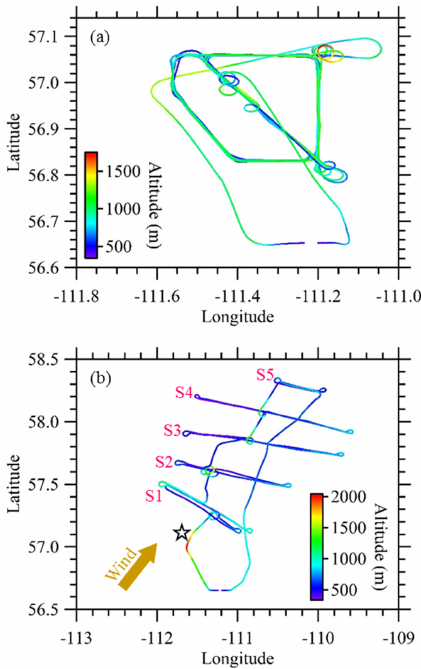
Figure 1. Examples of flight tracks for (a) emission and (b) trans- formation flights, which were flown on 28 August (F_8/28) and September 4 (F_9/4), 2013, respectively. F_8/28 was flown in a five- sided polygon pattern, encircling the SUN facility. F_9/4 was con- ducted in a Lagrangian pattern, involving five virtual screens (S1 to S5). A virtual screen corresponds to a specific downwind dis- tance from the OS source area and consists of level flight tracks perpendicular to the wind direction at multiple altitudes. Distances between the successive flight screens during F_9/4 were approxi- mately 30km, whereas distance between the OS center (shown ap- proximately by the open star) and the first screen (i.e., S1, which was located at the downwind edge of the OS source region) was also about 30km. Composite Google Earth images showing flight tracks are presented in Fig. S1 for F_8/28 and F_9/4. Altitude shown here indicates the ellipsoid